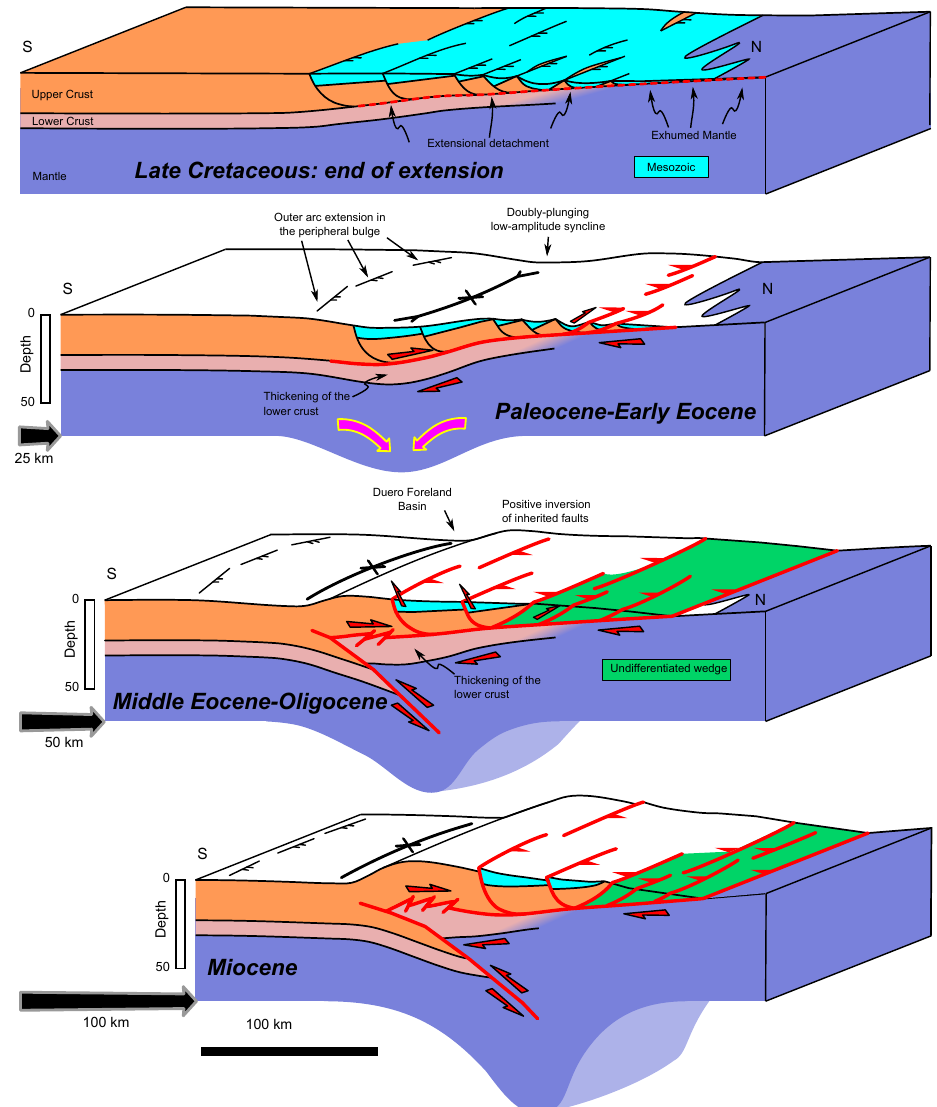
Fig. 22. Schematic evolution of subduction and development of the Pyrenean orogen in the Cantabrian domain.